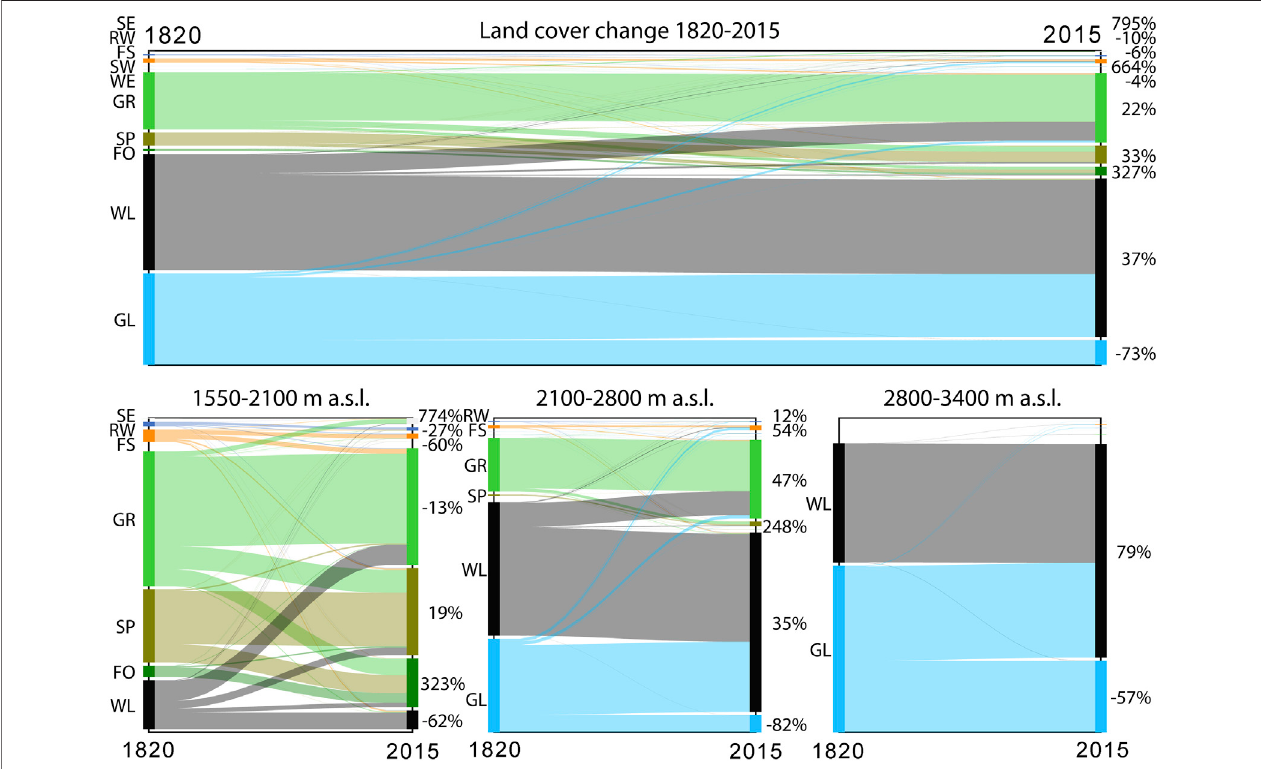
FIGURE 3 | Land cover transformation in the entire Jamtal between 1820 and 2015 (top) and for different altitudinal belts in the same period (bottom) . Percent values at right margins: relative changes up to 2015 compared to initial situation in 1820. Example bottom left: At altitudes between 1,550 and 2,100 m a.s.l. a great proportion ofwasteland(WL)transformedto grassland (GR)and somesmaller proportions tosparsely wooded areas (SP)and forests (FO). Only land cover types witha signi fi cant proportion are labelled in the bottom plots (SE, settlement; RW, running water; FS, fl uvial sediment; SW, stagnant water; WE, wetland; AL, arable land; GL,